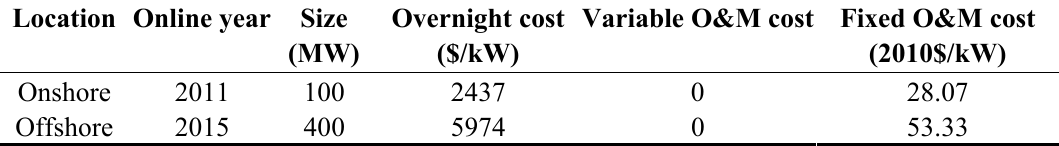
Table 6. Wind farm’s characteristics